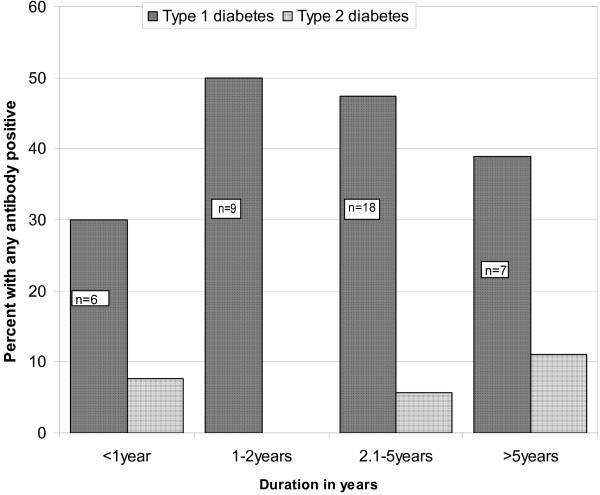
Prevalence of any antibody in patients with different durations of diabetes (time intervals since diagnosis). In patients with T1D, the prevalence of any antibody was highest {n = 9, (50%)} in the 1–2 year interval of the disease, and thereafter dropped slightly. In patients with T2D the prevalence was lowest in the 1–2 year interval of the disease, and slightly increased thereafter. There was no inverse correlation between duration of disease and autoantibodies in the patients with T1D.